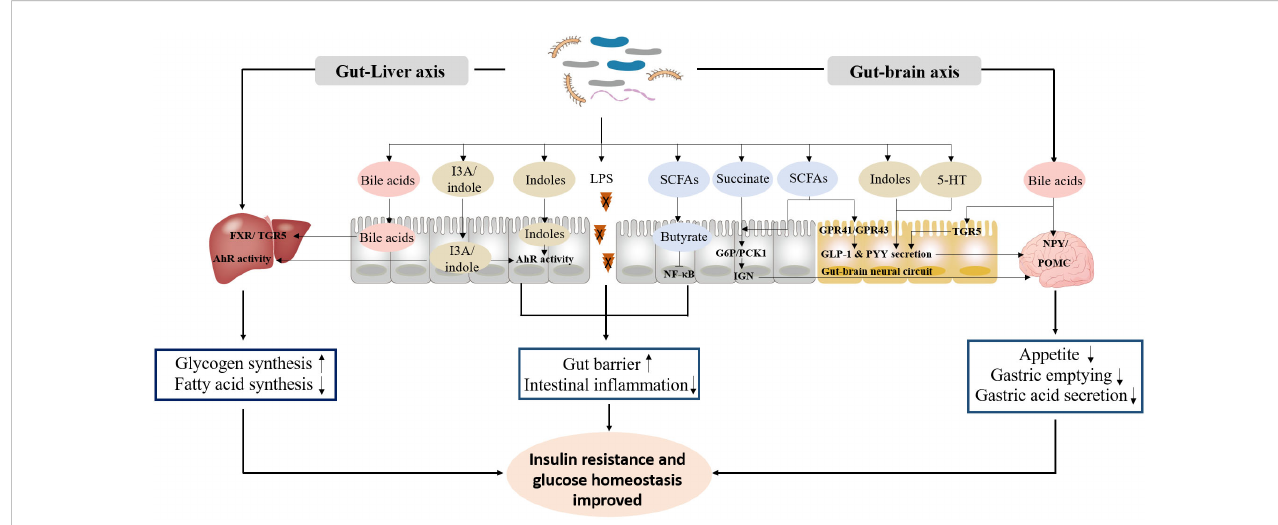
FIGURE 1 The primary functional mechanism of bacterial metabolites in the improvement of insulin resistance and glucose homeostasis. ① LPS, SCFAs and indoles improve gut barrier, and inhibit intestinal in fl ammation response. ② Bile acids, indoles, SCFAs, succinate and 5-HT promote GLP-1 and PYY secretion, and inhibit appetite, gastric emptying and gastric acid secretion through gut-brain axis. ③ Bile acids and indoles promote glycogen synthesis and insulin sensitivity, and inhibit fatty acid synthesis through gut-liver